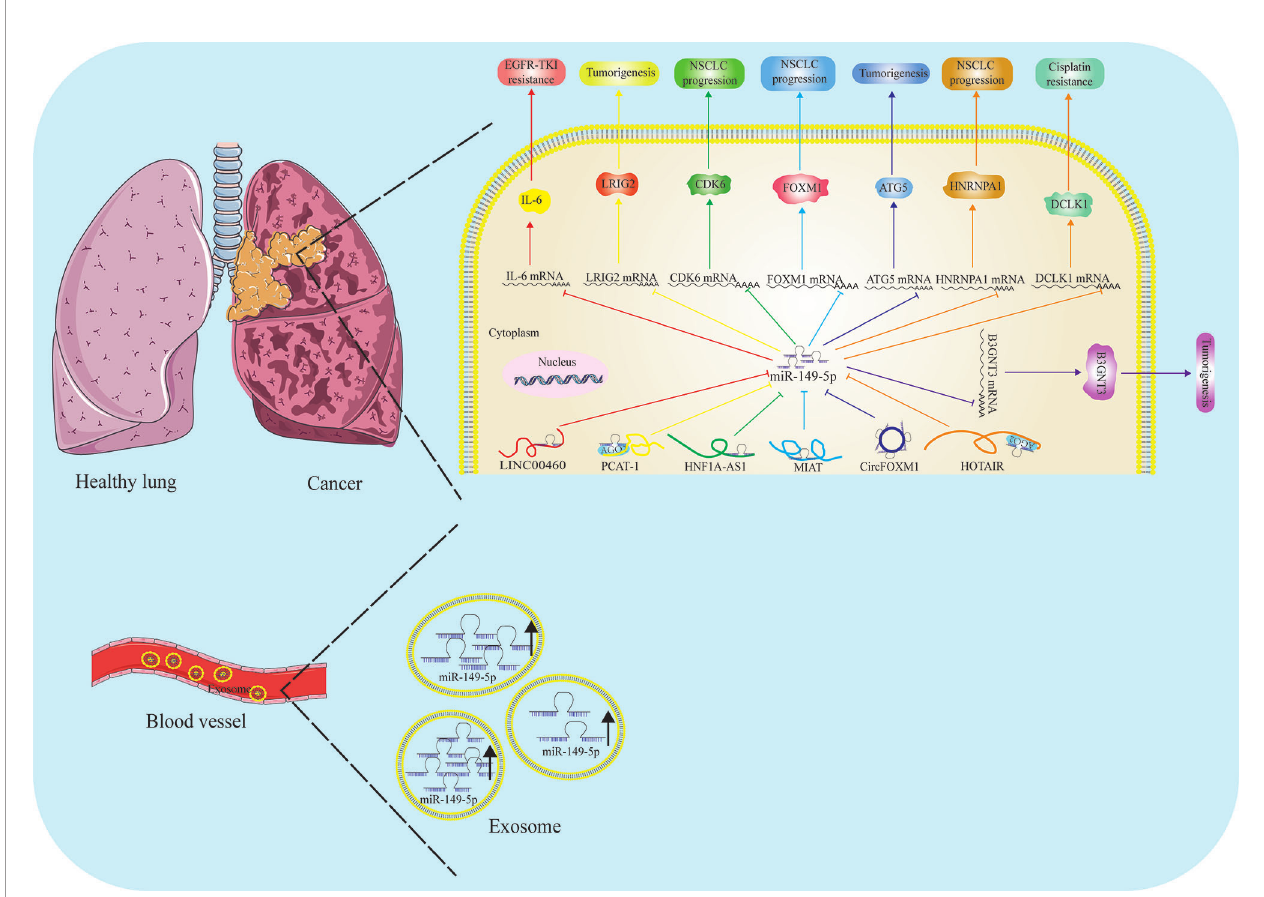
FIGURE 3 | Function and regulatory mechanism of miR-149-5p in lung cancer. The role of miR-149-5p in lung cancer is controversial. In NSCLC, miR-149-5p mostly is regarded as a tumor suppressor by targeting different genes, and is controlled by LINC00460, PCAT-1, HNF1A-AS1, MIAT, HOTAIR and circFOXM1. Paradoxically, high levels of miR-149-5p are found in serum exosome, and promotes LUAD